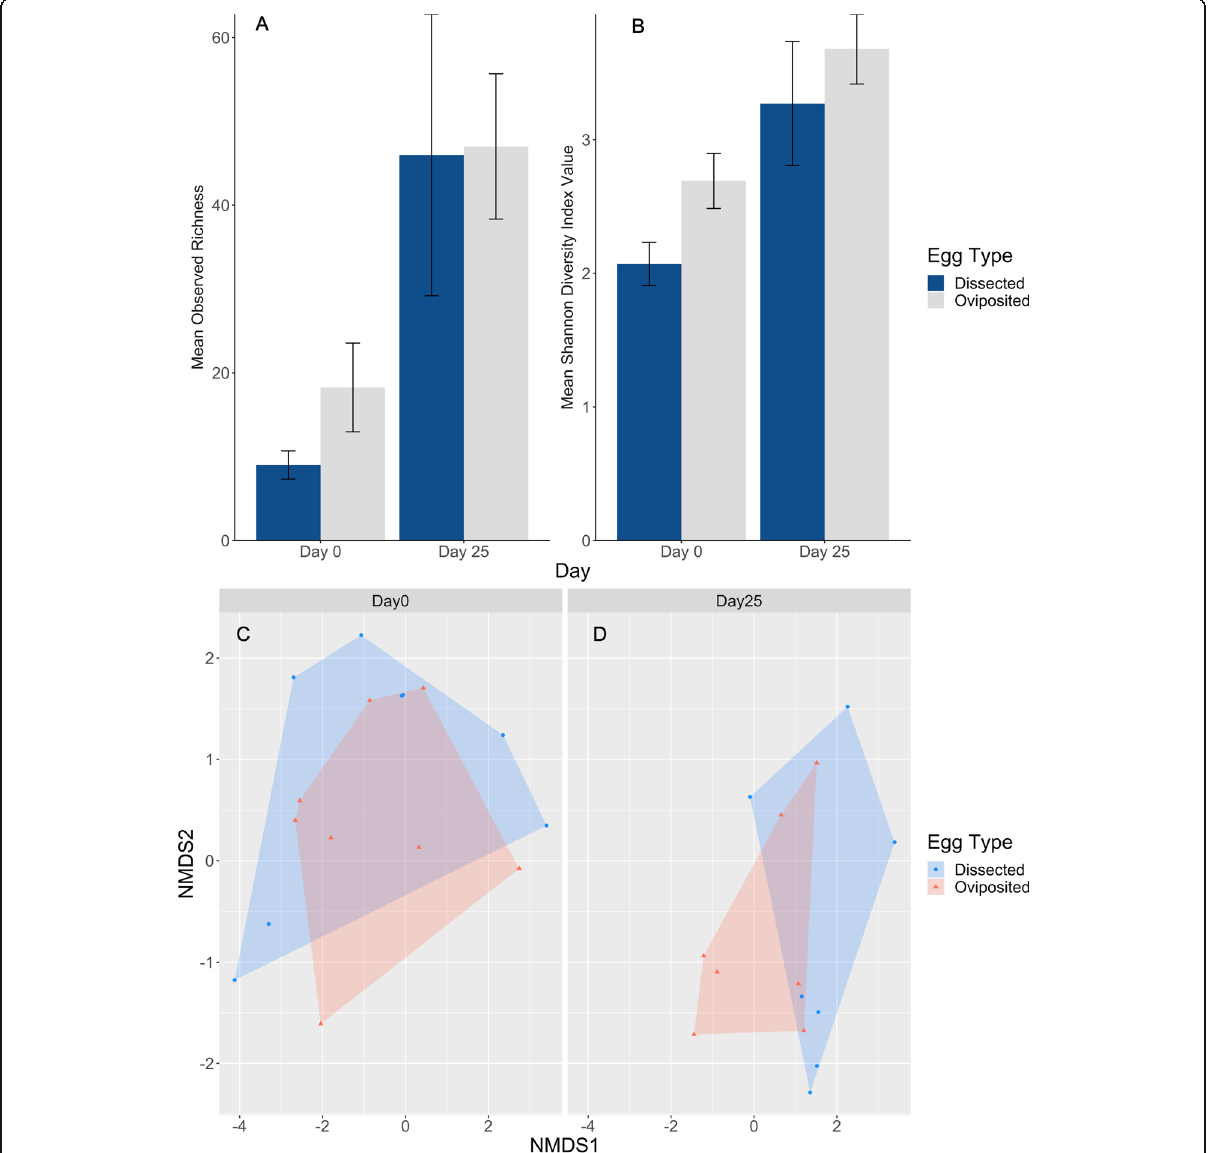
Fig. 4 A Mean observed richness ( ± SE) and B Mean Shannon diversity index values ( ± SE) for dissected and oviposited S. virgatus eggs. Communities were sampled at Day 0 and Day 25 of incubation in soil slurry. Non-metric multidimensional scaling plots were created by using Bray Curtis distance to calculate pairwise distances based on community composition on C ) Day 0 and D ) Day 25. Three dimensions were used to calculate distances, but only the most influential two are pictured